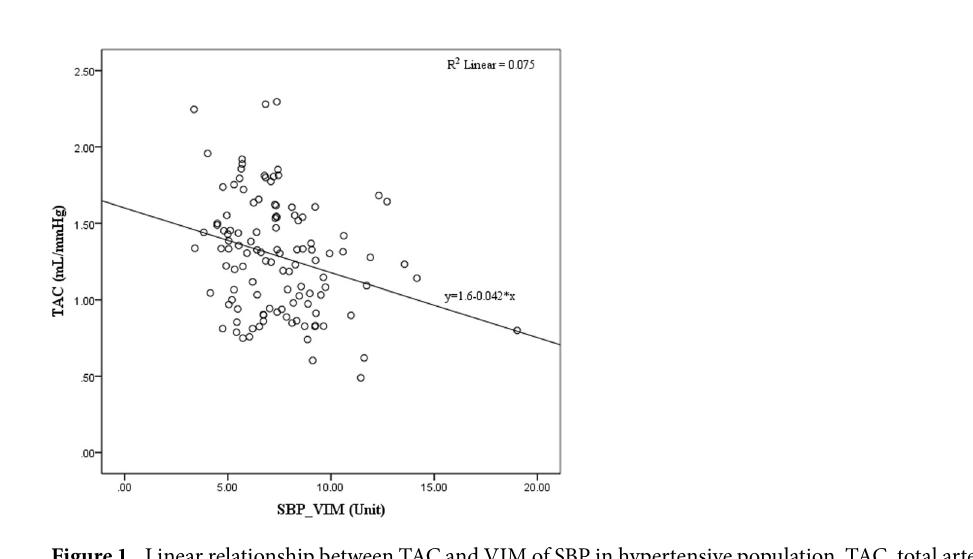
Figure 1. Linear relationship between TAC and VIM of SBP in hypertensive population. TAC, total arterial compliance; SBP, systolic blood pressure; VIM, variation independent of